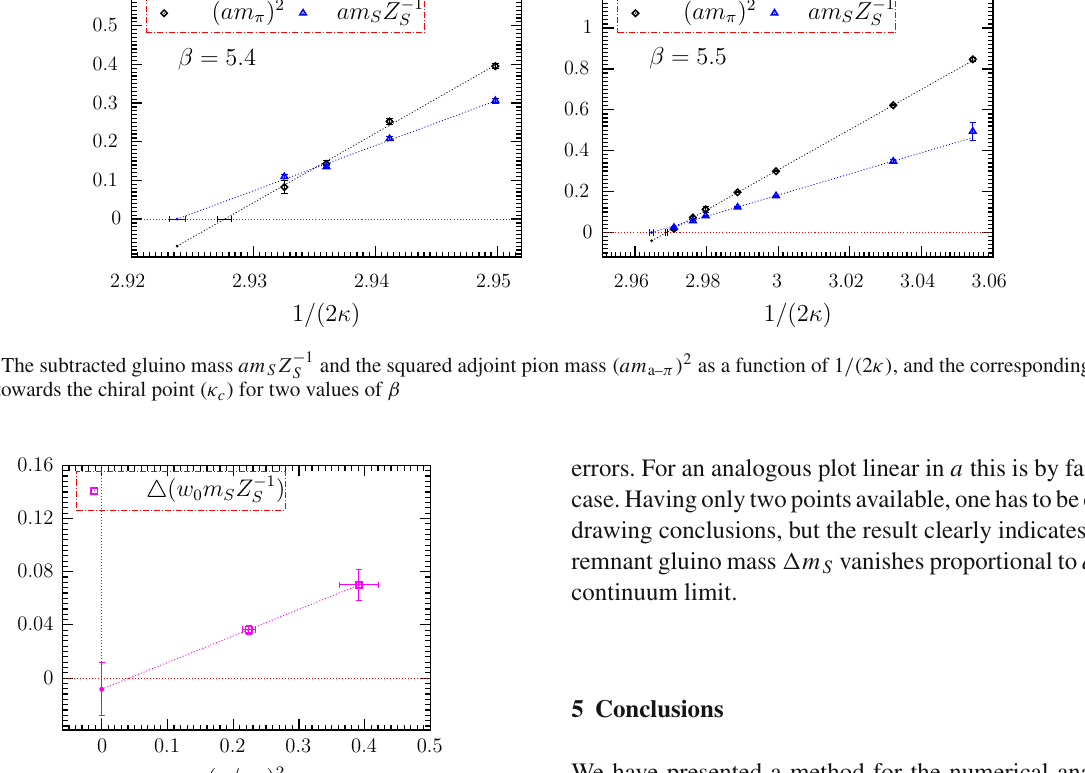
Fig. 2 The remnant gluino mass (cid:15)(w 0 m S Z − 1 functionofthelatticespacingsquared.Thecommonscaleissetthrough the gradient flow parameter w 0